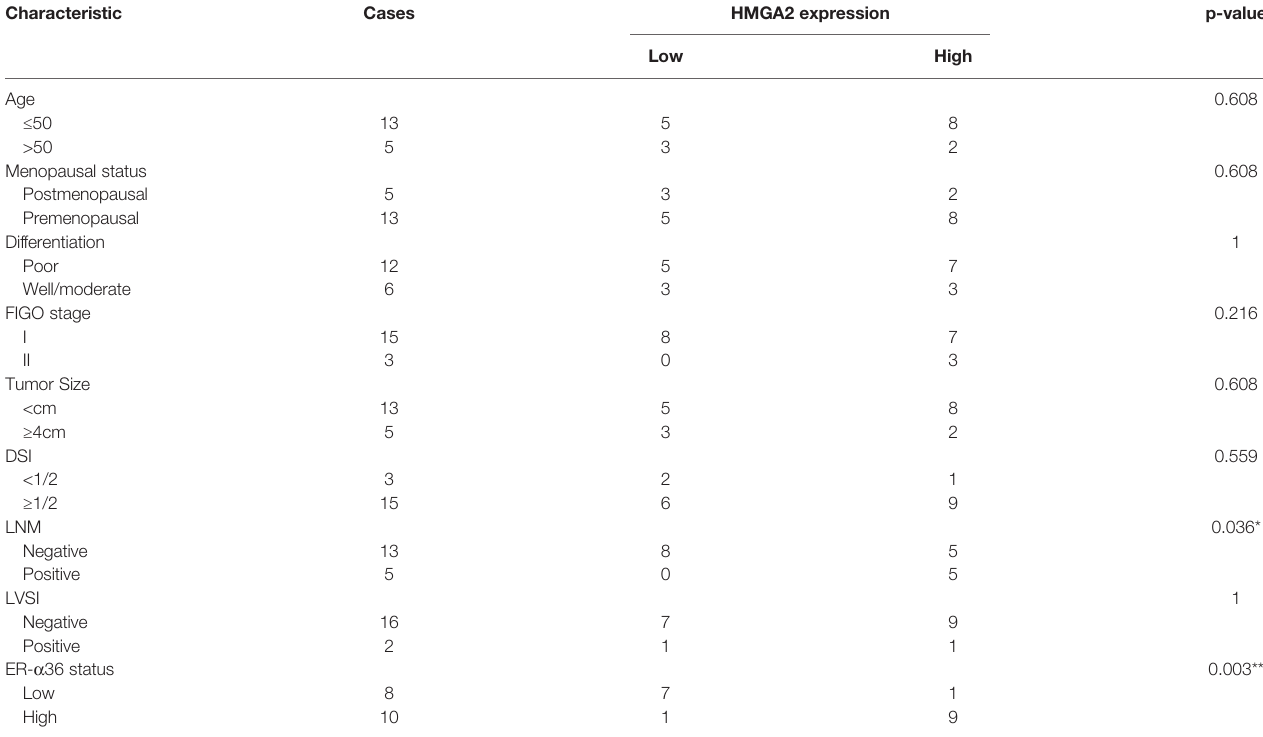
TABLE 6 | Association between HMGA2 expression and clinicopathologic characteristics of cervical AC patients. Characteristic